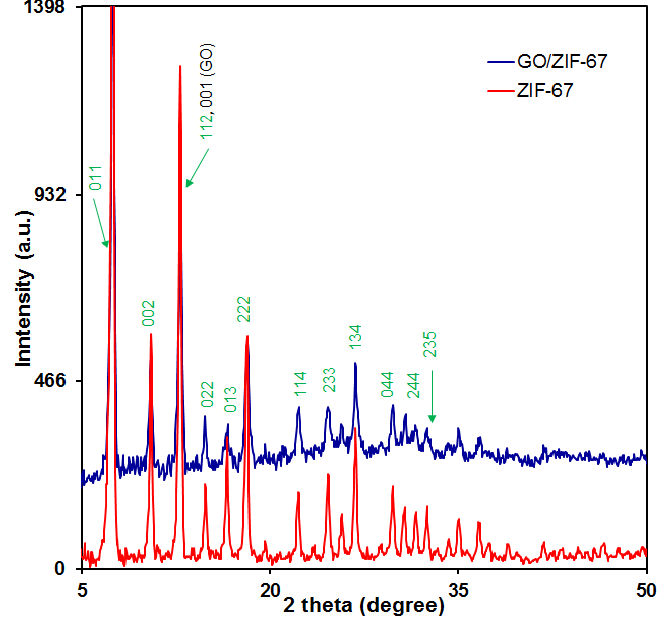
Figure 3. XRD patterns of the ZIF-67 nanoparticles and the GO/ZIF-67 nanocomposites.